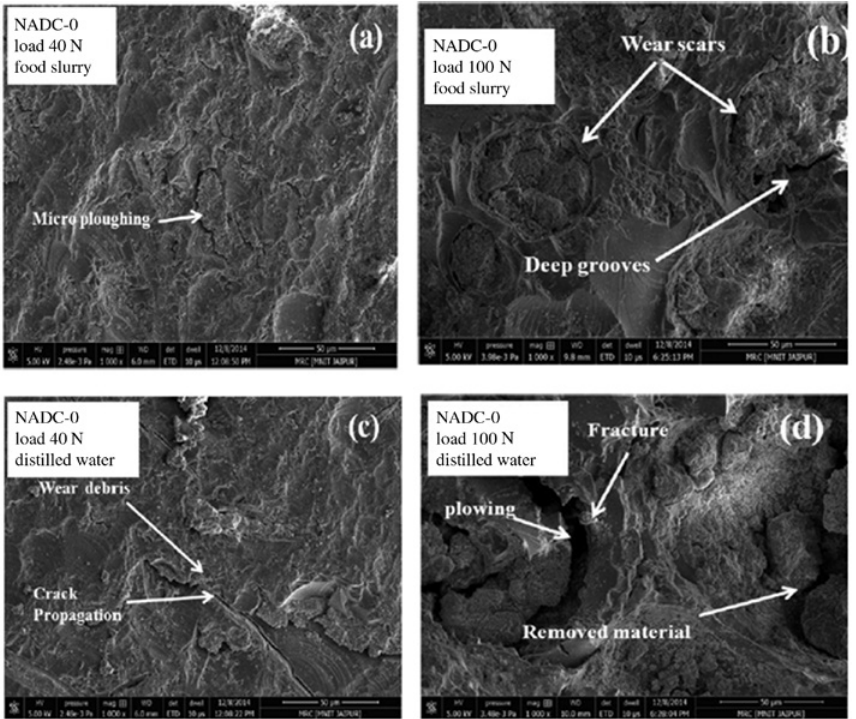
Figure 10: FE-SEM images of worn surfaces of dental composite without nanoalumina under the chewing speed of 5 mm/s, temperature of 25 ° C and varying normal load and medium of (a) 40 N, food slurry; (b) 100 N, food slurry; (c) 40 N, distilled water; and (d) 100 N, distilled water.